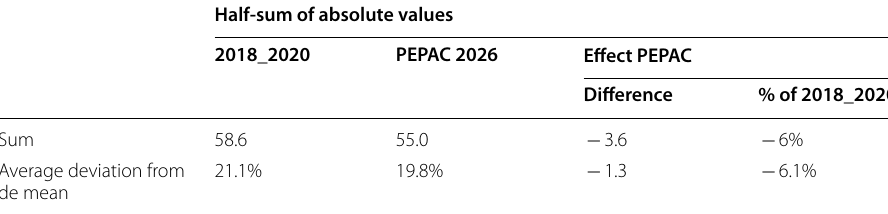
Table 3 Equity index calculated before and after the new PEPAC rules